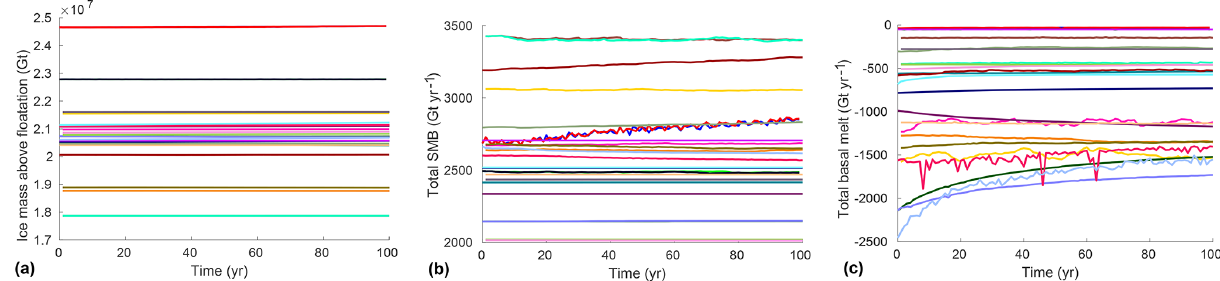
Figure 6. Evolution of Antarctic ice sheet mass above floatation and external forcings in the ctrl experiment. (a) Total mass of ice above floatation (Gt), (b) total SMB applied at the ice surface (Gtyr − 1 ), and (c) total basal melting rate (Gtyr − 1